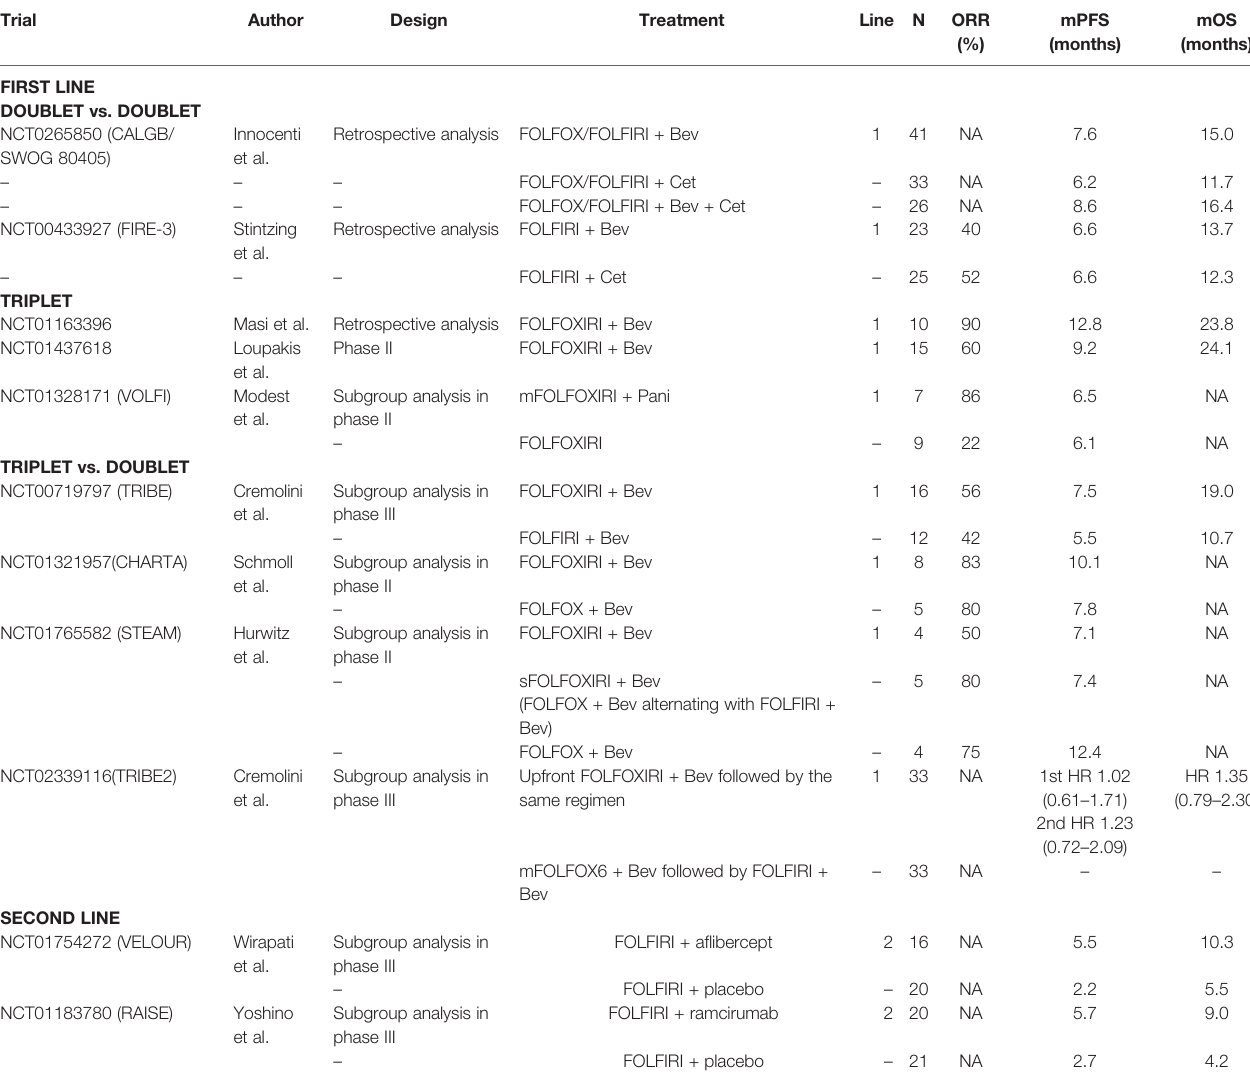
TABLE 1 | Ef fi cacy of conventional chemotherapies for BRAF -mutated metastatic colorectal